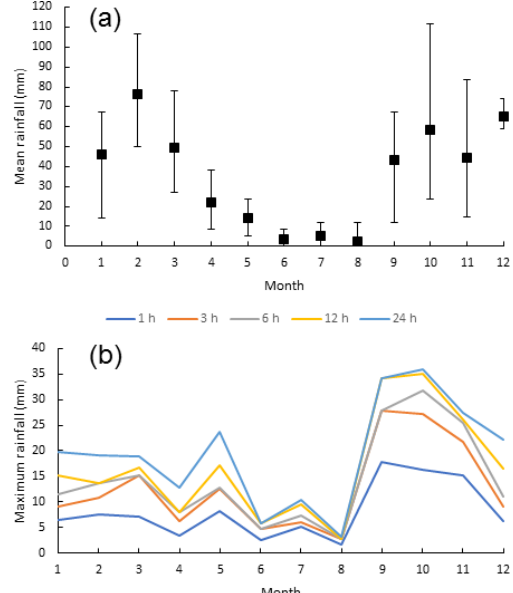
Figure 2. (a) Mean monthly rainfall (mm) observed at Lentia sta- tion (Fig. 1) between 2010 and 2014 (error bars also indicate mini- mum and maximum values). (b) Maximum monthly rainfall within 3, 6, 12, and 24h (data from INGV